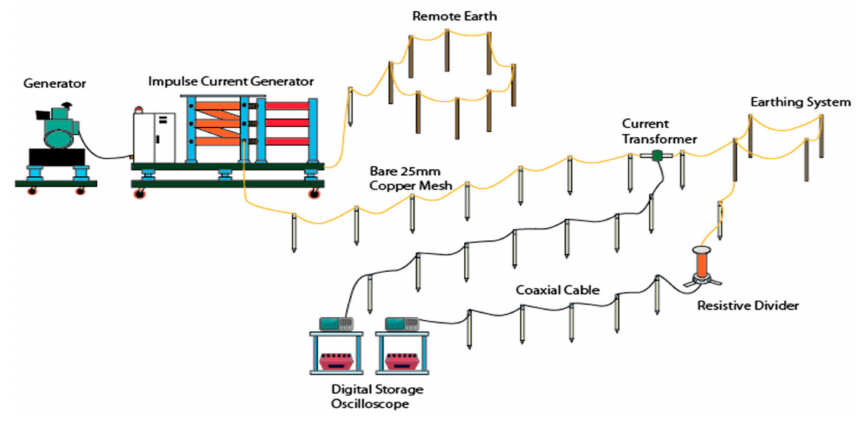
Figure 4. Test set